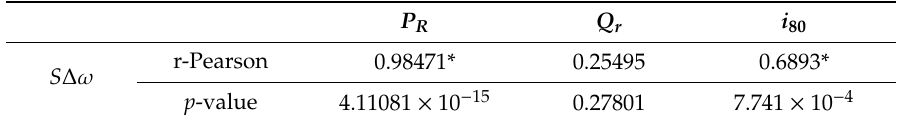
Table A6. Results of the analysis of variable correlation using the Pearson method for the process of corn grinding. P R Q r i 80 r-Pearson 0.98471* S ∆ ω